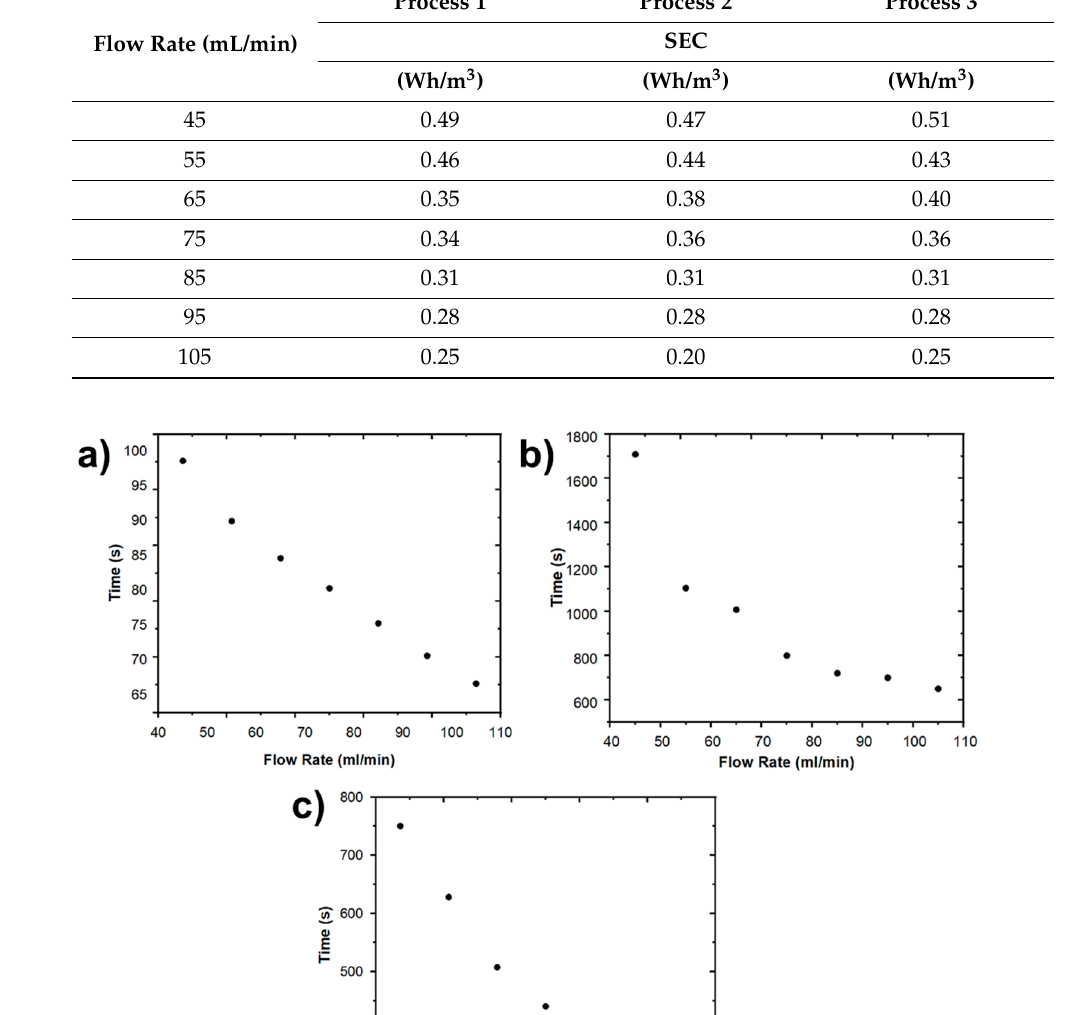
Table 3. Time and energy consumed for various flow rates using three different types of processes (NaCl 0.4 M, 1.2 V).